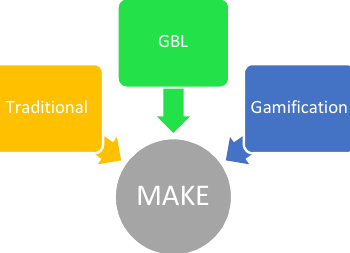
Figure 4. Evaluation of three teaching methods using the MAKE framework.